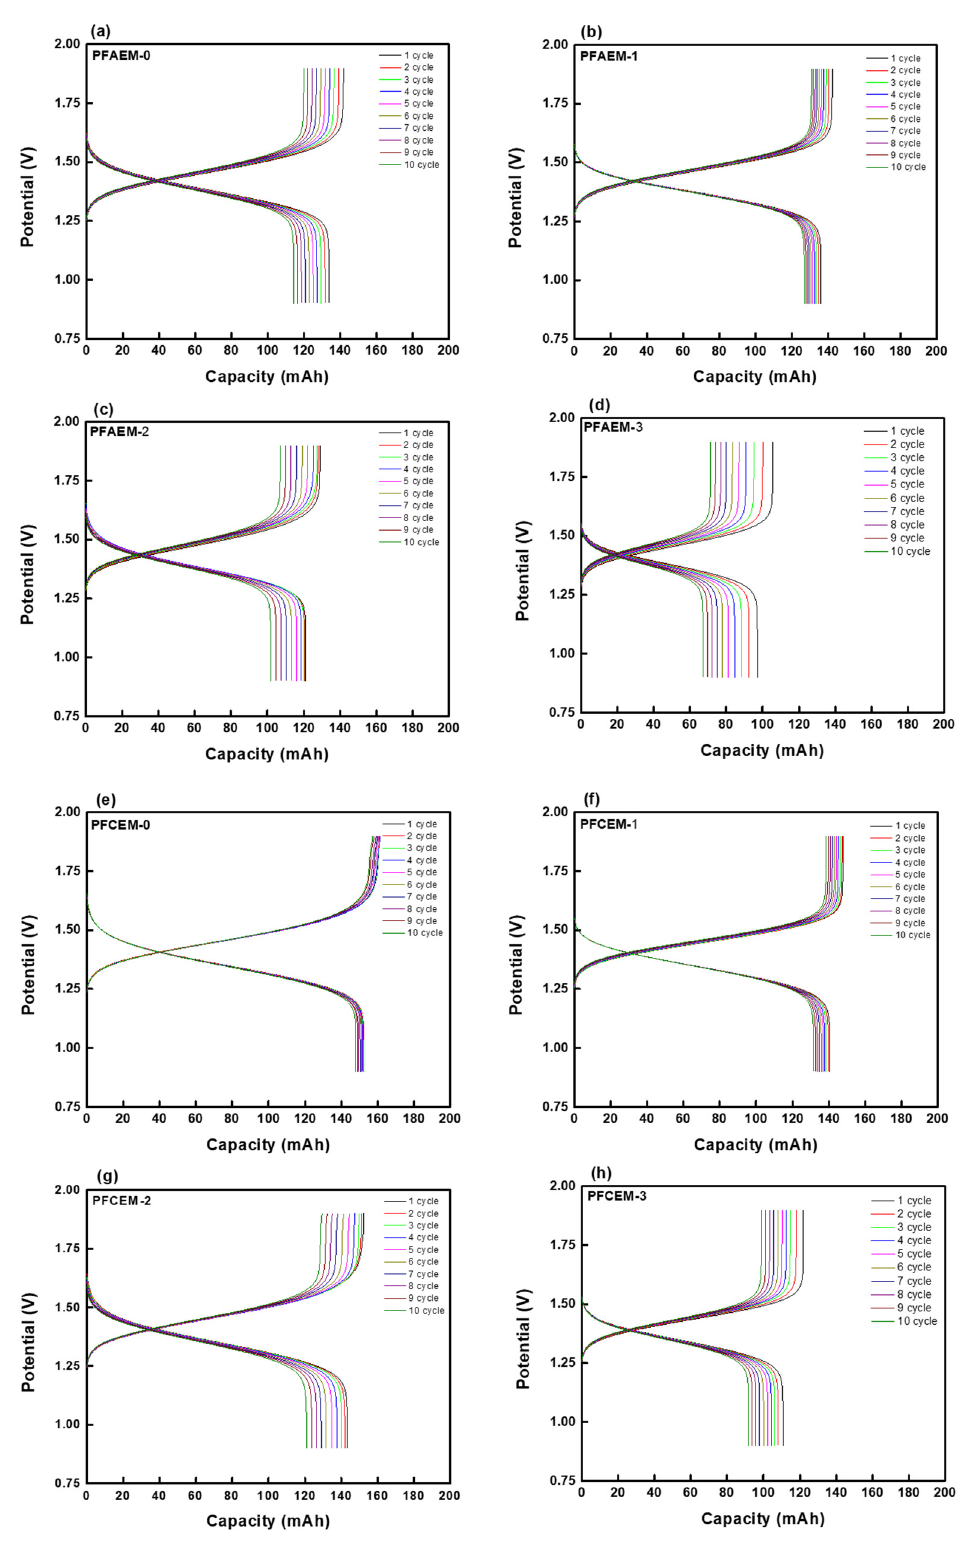
Figure 11. The charge–discharge curves in VRFB systems employing different IEMs (( a ) PFAEM-0, ( b ) PFAEM-1, ( c ) PFAEM-2, ( d ) PFAEM-3, ( e ) PFCEM-0, ( f ) PFCEM-1, ( g ) PFCEM-2, and ( h ) PFCEM-3, respectively). Table 6. Battery efficiencies of commercial membranes and PFIEMs.